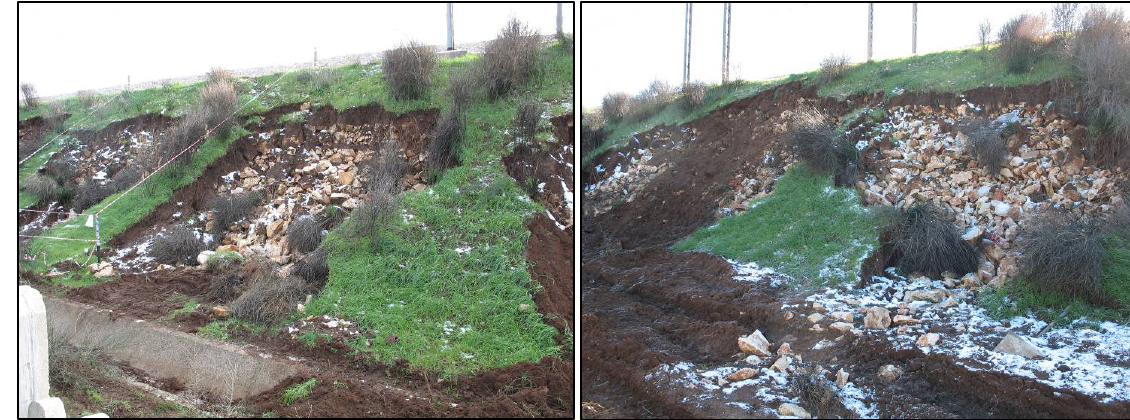
Fig. 14. Unravelling/sliding failures observed along the slopes of the remaining portion of the Acquaviva embankment.